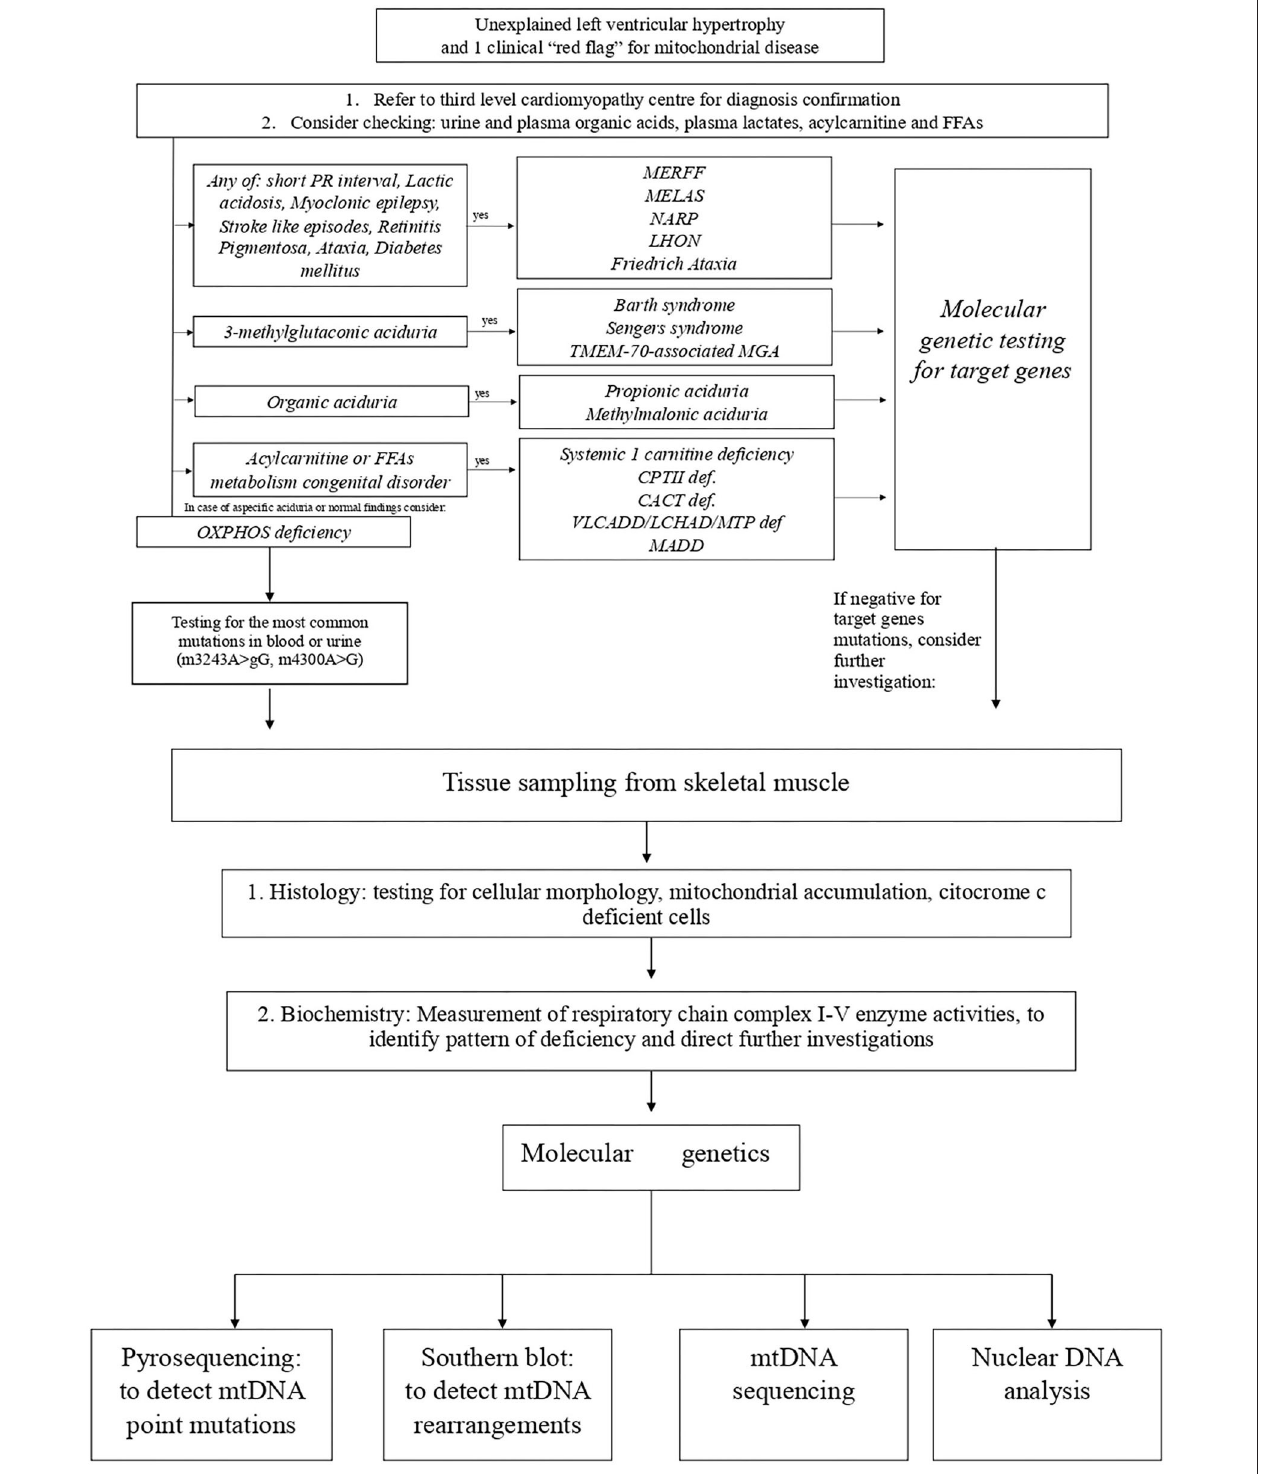
FIGURE 5 | Proposed algorithm for the diagnosis of mitochondrial cardiomyopathies. CACT, carnitine-acylcarnitine translocase; CTPII, carnitine palmitoyltransferase II; FFA, free fatty acids; LCHAD/MTP, long-chain 3-hydroxyacyl-CoA dehydrogenase deficiency; LHON, Leber’s hereditary optic neuropathy; MADD, multiple-acyl-CoA dehydrogenase deficiencies; MELAS, mitochondrial encephalomyopathy, lactic acidosis, stroke-like episodes; MERRF, myoclonic epilepsy with ragged red fibers; MGA, methylglutaconic aciduria; NARP, neurogenic muscle weakness with sensory neuropathy; VLCADD, very-long-chain acyl-CoA dehydrogenase deficiency.